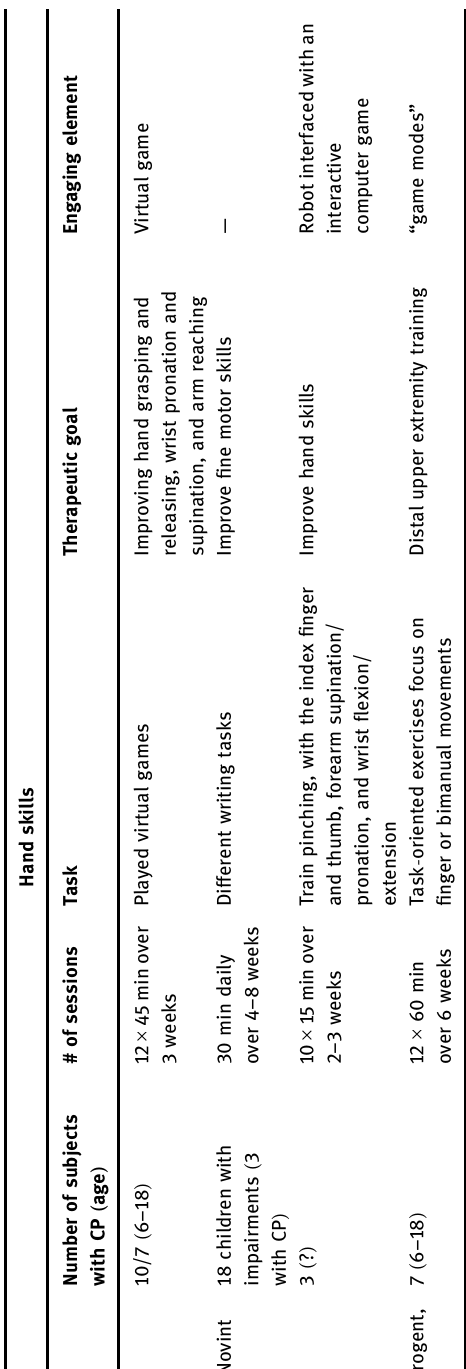
therapy for another 5 weeks. The order of the interventions was randomized. The interventions targeted either forearm supination ( roll motion of the forearm ) or wrist extension, depending on the children. Motor performance was eval - uated before the intervention and after each session using motion capture. Results suggested that the robotics inter - vention improved targeted movements and that improve - ment was more signi fi cant when the robotic intervention preceded the conventional therapy. There was, however, no signi fi cant di ff erence between robotic and conventional therapy in forearm supination or wrist extension improve - ment. The second article [ 52 ] employed a Nao [ 53 ] robot to play a Mirror ( Imitation game where the children mirror the robot ’ s movements ) and “ Simon Says ” game ( the child obeys the robot ’ s command if it contains “ Simon says ” ) with the children. They assessed improvement with the QUEST [ 54,55 ] and Mallet [ 56 ] scales. The QUEST measures dissociated movement, grasp, weight - bearing, and protec - tive extension abilities. The score ranges from 0 to 100 with a higher score representing better quality of move - ment. Mallet is a test that measures active abduction, external rotation, and movement of the hand to the head, back, and mouth and gives a score between 1 and 25. Their results not only showed motor improvement, but also increased motivation and engagement in the robotics ses - sions. This is the only article that we found in this review that reported results on engagement and motivation. None of the other studies employ social robots, but several studies used robots coupled with a virtual environment or a visual interface. The ArmeoSpring robot associated with virtual 3D environment was used in ref. [ 57 ] . During the robotic ses - sions, participants played exergames [ 58 ] ( technology - driven physical activity, usually involving video games ) that simulated meaningful tasks ( e.g ., reaching tasks ) tar - geting di ff erent upper arm joints. The therapist adjusted the number of repetitions and level of di ffi culty of each game according to the patient ’ s abilities. Patients were evaluated before and after the intervention with the QUEST and the Melbourne Assessment of Unilateral Upper Limb Function. The Melbourne Assessment [ 59 ] measures the quality of unilateral upper - limb motor function based on items involving reach, grasp, release, and manipula - tion in neurologically impaired children. Scoring criteria include range of movement, target accuracy, fl uency, T a